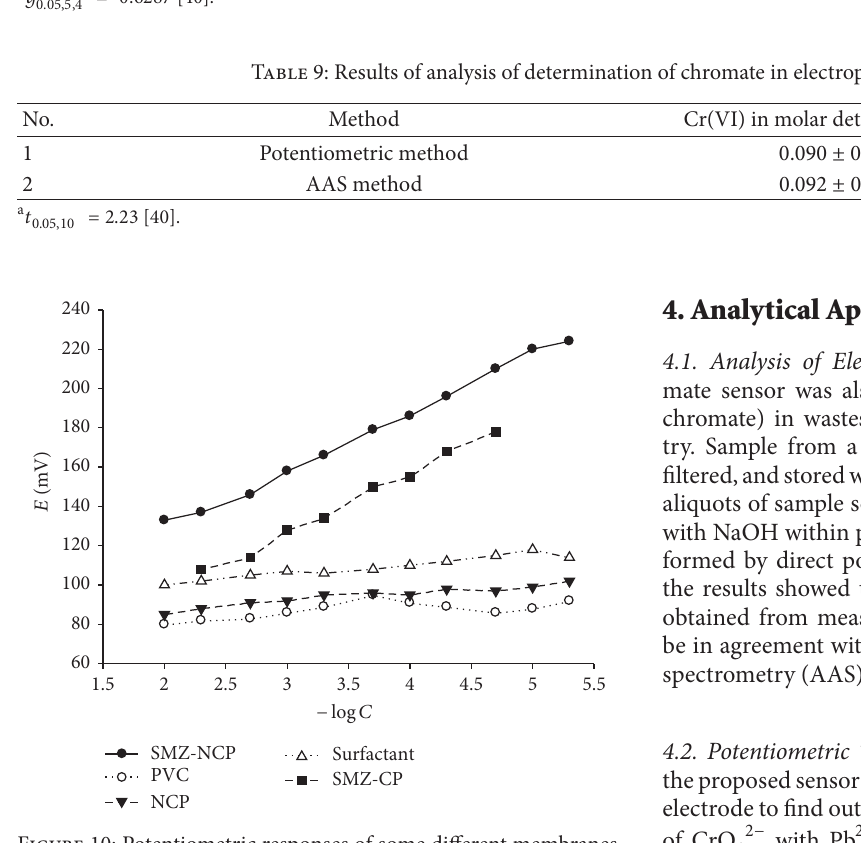
F 10: Potentiometric responses of some different membranes containing PVC, NCP, HDTMA surfactant, SMZ-CP, and SMZ- NCP towards